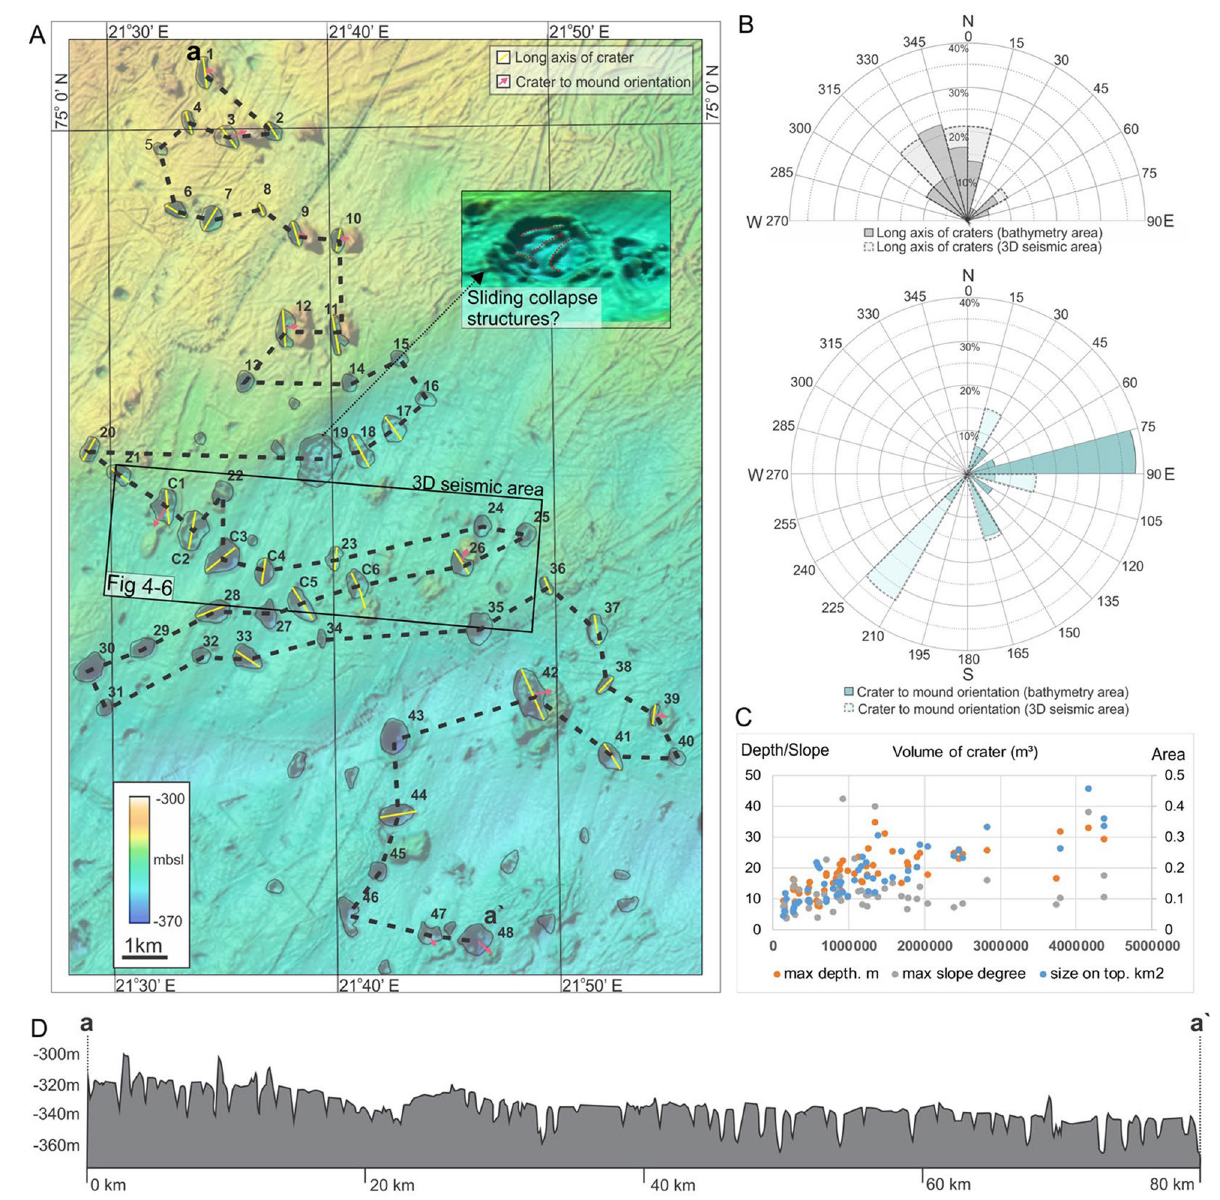
Figure 2. The study area with 54 large craters and 15 mounds. ( A ) bathymetric map. The yellow lines represent the long axis of craters and pink arrow the crater to mound orientation. The craters that show an asymmetry of > 1.6 are regarded as elongated, and included in the orientation measures. These orientations are presented in a rose diagram in inset ( B ). The data show a NNW trend of crater orientations, and that mounds tend to be located on the eastern side of the crater-mound couples. ( C )-panel showing statistical data where crater volume (m 3 ) is plotted against surface area (m 2 ), maximum depth (m) and maximum slope (degrees). ( D ) profile through all